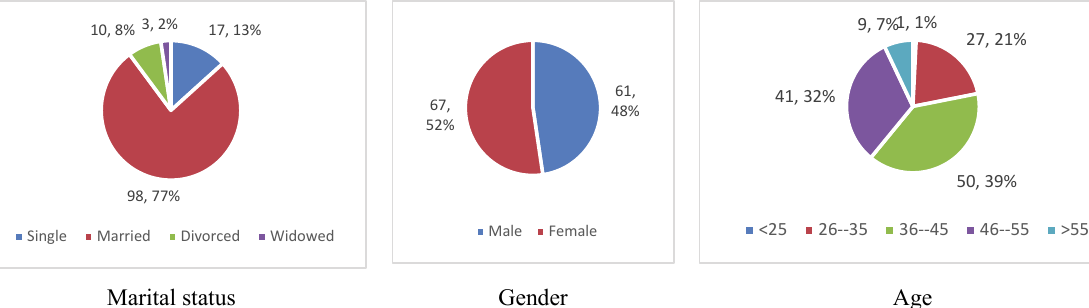
Fig. 1. Respondents Demographic Profiles